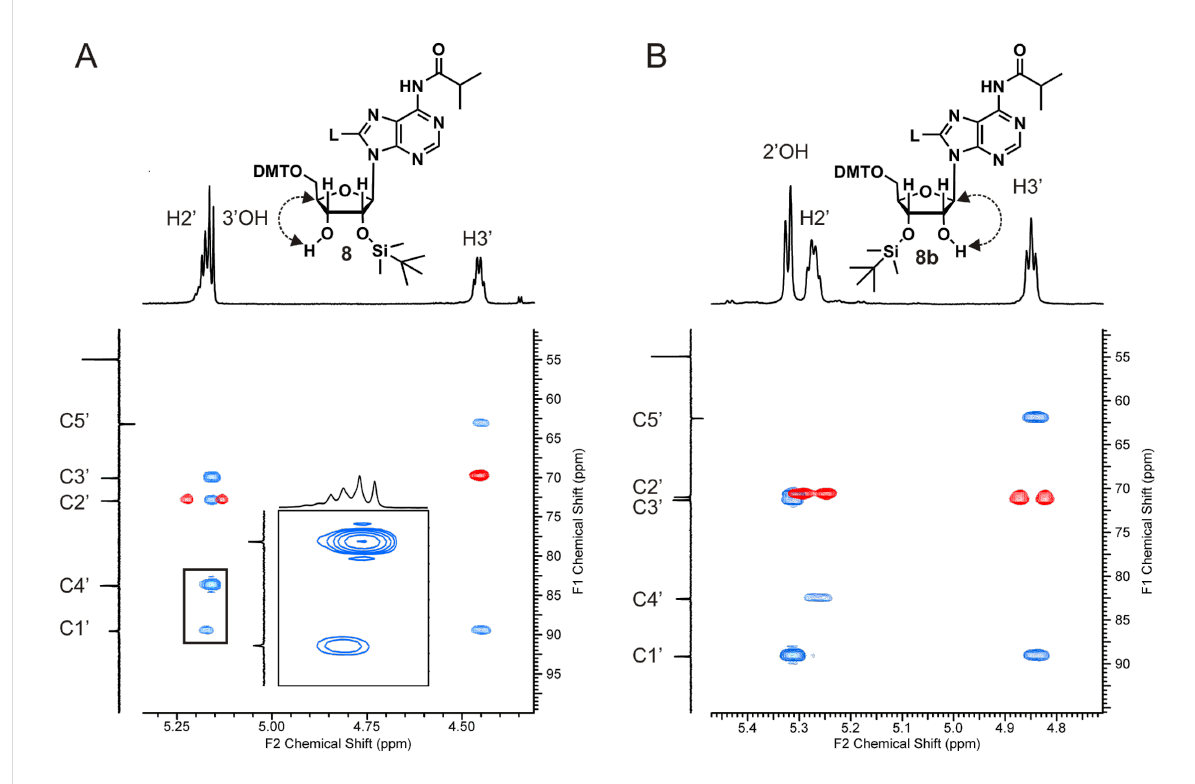
Figure 1: Characterization and assignment of the TBDMS isomers via HSQC (red) and HMBC (blue) NMR measurements. A) The merged 1 H signal at 5.17 ppm results from the H2’ and an OH group, since the H3’ can be clearly identified through the HMBC correlation with C5’. The zoomed region shows the HMBC correlation of the OH group with C4’, which together with the weaker signal between H2’ and C1’ identifies this nucleoside as the 2’- O -TBDMS isomer. B) The H3’-signal is distinct from the H3’ signal in A in its multiplicity, and the OH group has a HMBC correlation with C1’, not with C4’, which identifies this nucleoside as the 3’- O -TBDMS isomer.